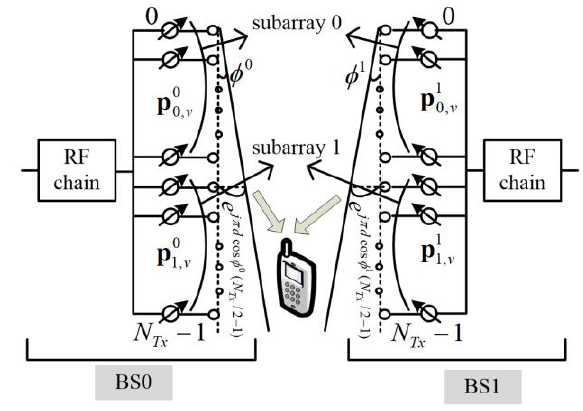
Figure 1. An example of Tx beamformers at two neighboring BSs when the proposed beam weight generation method is used.